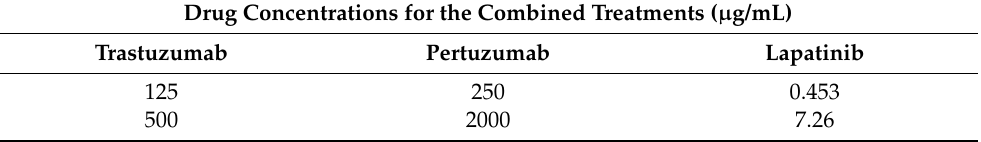
Table 2. Concentrations of trastuzumab ( µ g/mL), pertuzumab ( µ g/mL) and lapatinib ( µ g/mL) used in the combined treatments. Cells were exposed to drug for 72 h before cytotoxicity evaluation.